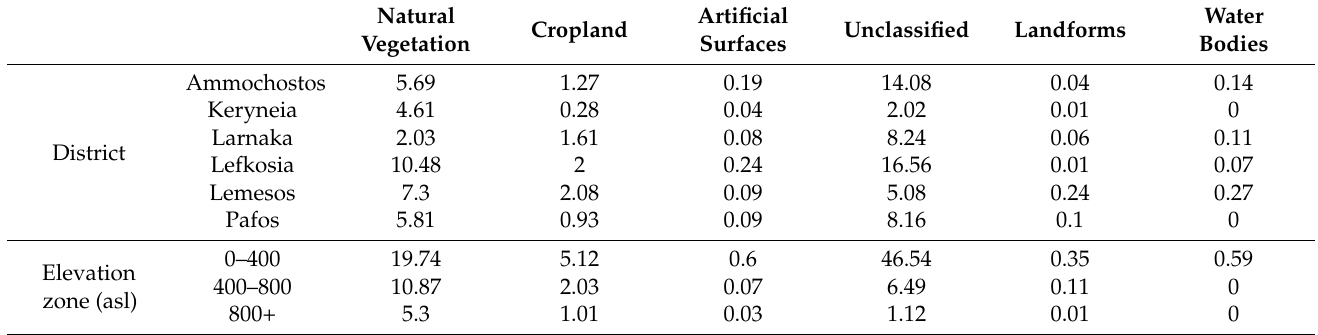
Table 3. Percentage (%) of land cover categories by administration district and elevation zone.